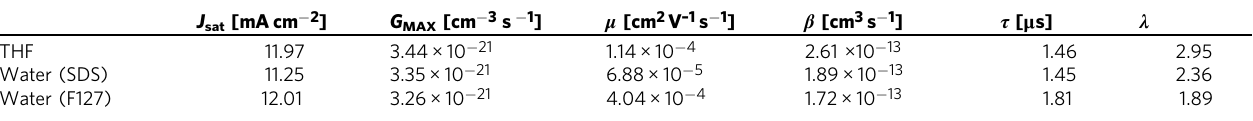
Summary of calculated charge generation, collection, transport and recombination parameters in optimized P3HT:o-IDTBR solar cells: saturation current ( J sat ); maximum rate of free charge carrier generation in saturation regime ( G MAX ); charge carrier mobility ( μ ) and bimolecular recombination coef fi cient ( β ) from photo-CELIV measurements; charge carrier lifetime ( τ ), and recombination exponent ( λ ) from TPV&CE